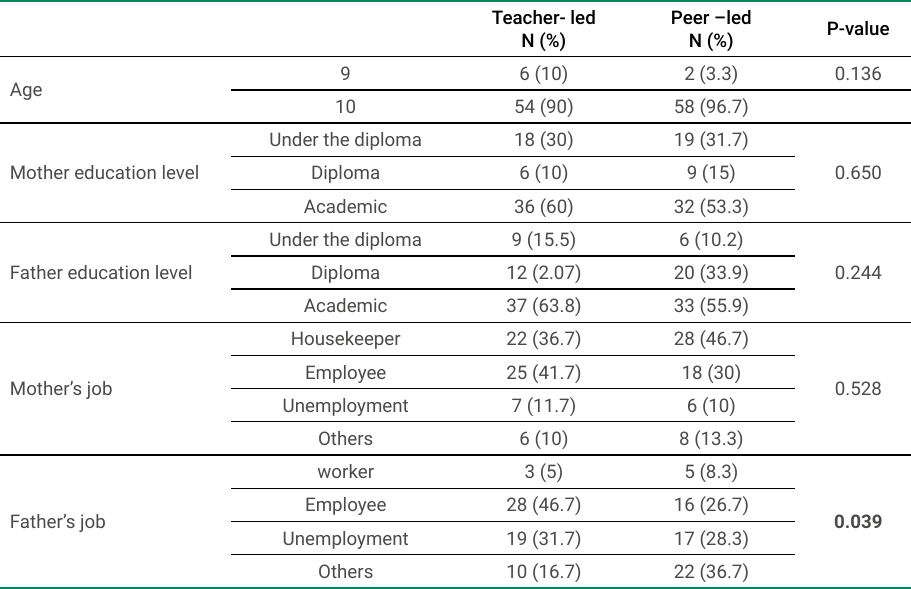
Table 1. Demographic variables between the two groups of PLE and TLE